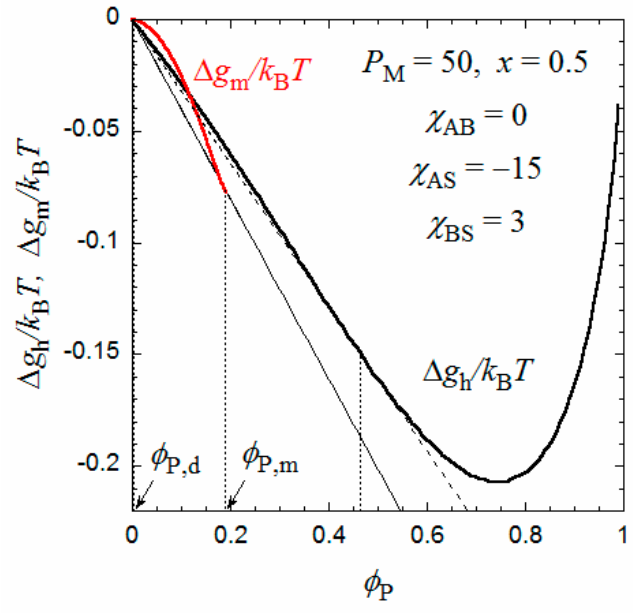
Figure 2. Concentration dependences of Δ g m and Δ g h at x = 0.5 calculated by Equations (9) and (10).